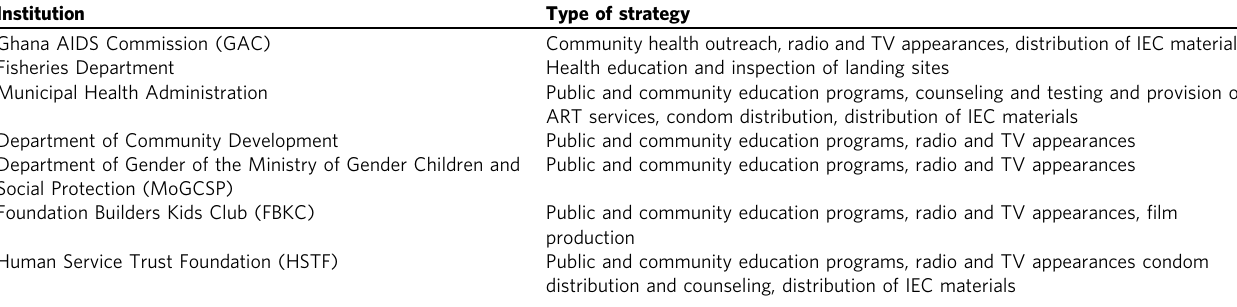
Table 5 HIV and AIDS education strategies of institutions.